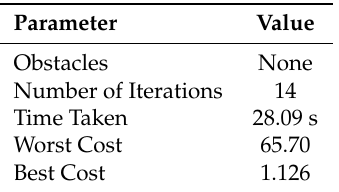
Table 3. Flight B Real Time Trajectory Planner